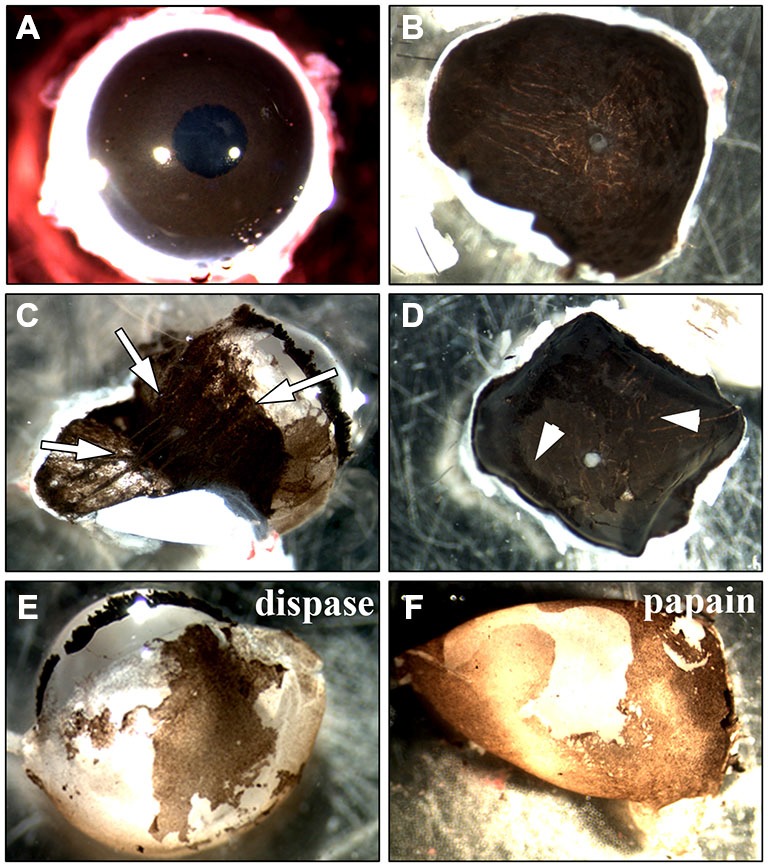
Methods used for the isolation of RPE cells. Two main approaches to isolate RPE cells from adult rat eyes have been tested. (A) The first approach involved the incubation of the whole eye in proteinase (Edwards, 1977, 1981; Mayerson et al., 1985; Chang et al., 1991; Sakagami et al., 1995; Pinzon-Duarte et al., 2000). After the incubation, the eye was opened and the anterior parts including the retina were removed. (B) For the second method sclera/choroid/RPE sheets were incubated in protease (Wang et al., 1993; Kreppel et al., 2002). (C) Trypsin, collagenase or hyaluronidase all dissolved the eye tissue so that the choroid became disintegrated and an isolation of RPE cells was impossible (white arrows). The same happened when the sclera/choroid/RPE sheet was incubated in these proteinases as has been commonly used for human tissue (Maminishkis et al., 2006; Gullapalli et al., 2008; Sonoda et al., 2009; Pfeffer and Philp, 2014). (D) Reducing the incubation time in trypsin, collagenase or hyaluronidase kept the choroid intact but in most cases, the pigmented RPE cells were still attached to Bruch’s membrane so that it was impossible to peel off the cells (see arrowheads). The incubation of the sheet in dispase, accutase or papain did not lead to an appropriate digestion of Bruch’s membrane and many RPE cells stayed attached to the underlying tissue. (E) Incubating the whole eye in 2% dispase (Chang et al., 1991) yielded ~25,000 cells/eye after 50 min. (F) Papain (20 U/ml) digestion resulted in the isolation of ~40,000 cells after 50 min (see Figure 1).